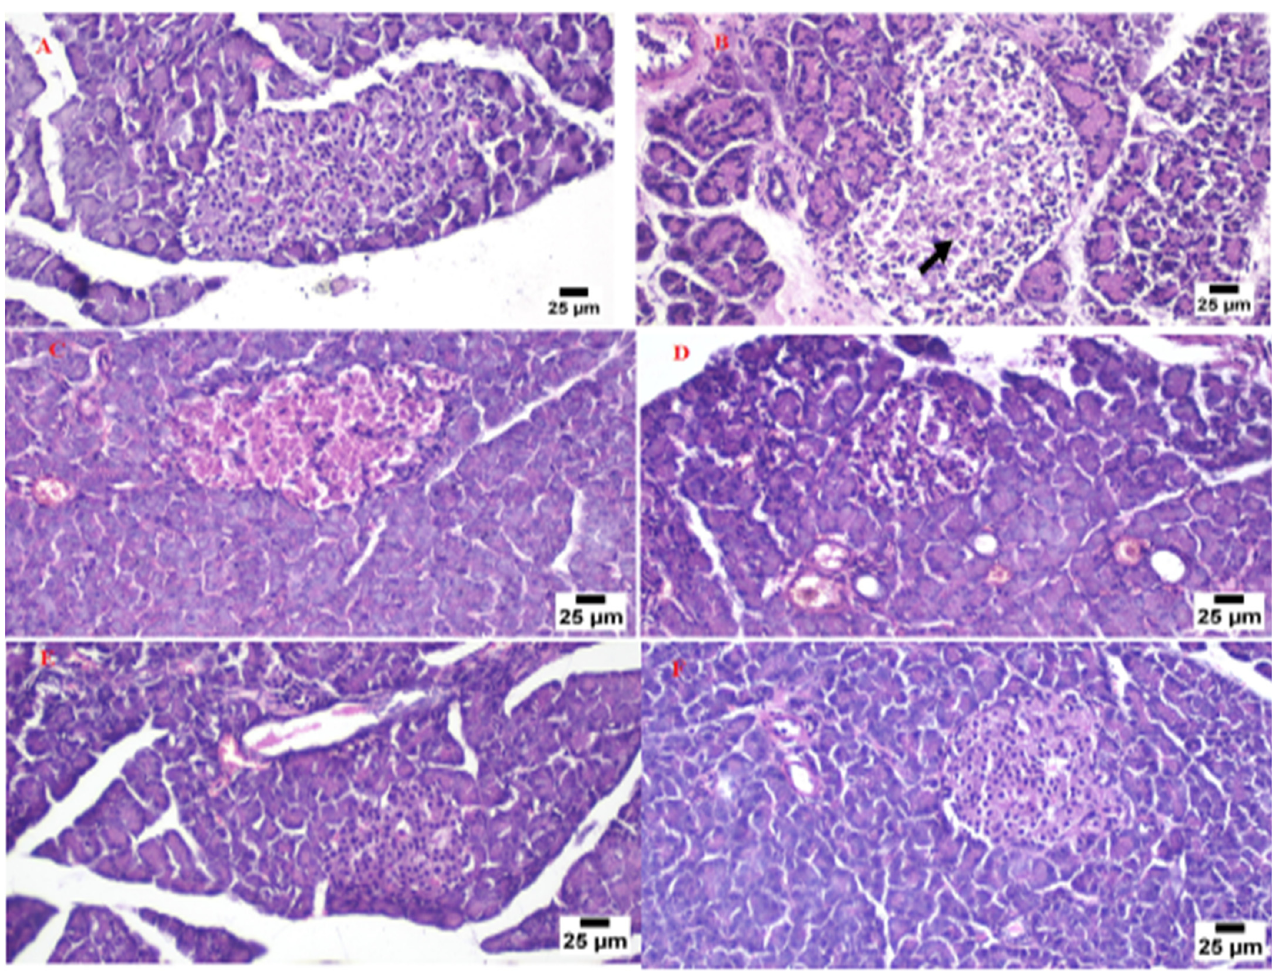
Figure 11. Photomicrograph for the pancreas tissue of the control group ( A ), model group ( B ), mar- keted product ( C ), non-SNEDDS glimepiride tablet ( D ), and SNEDDS glimepiride tablet ( E , F ).